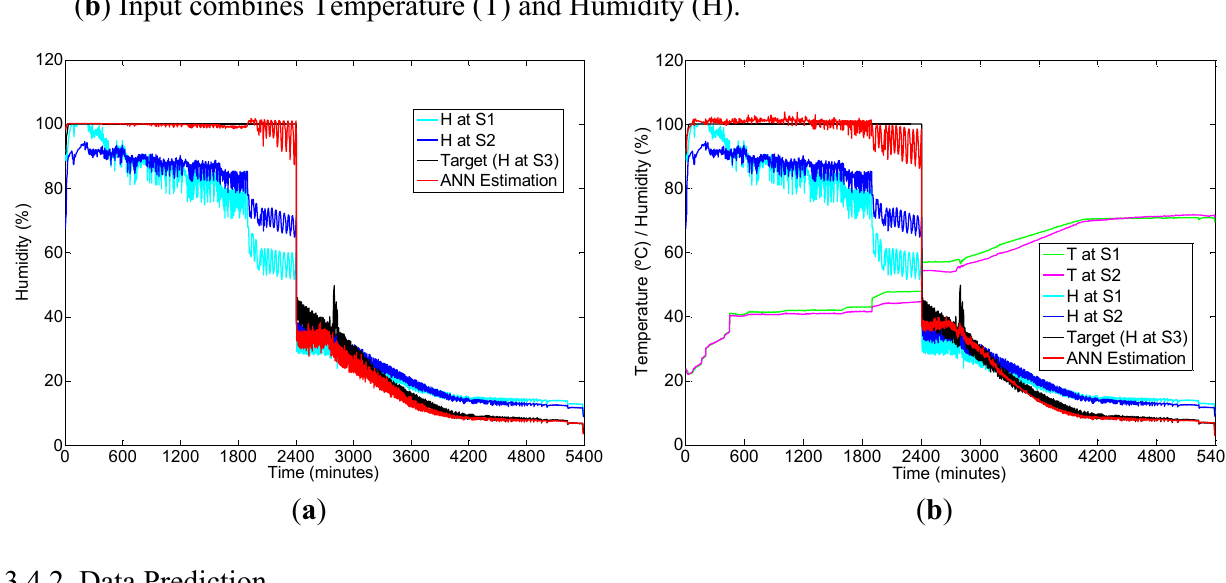
Figure 7. Example of ANN estimation of Humidity (H) at Sensor 3 (S3) for one drying process using Sensors 1 and 2 (S1 and S2) as input. ( a ) Input is only Humidity (H). ( b ) Input combines Temperature (T) and Humidity (H).